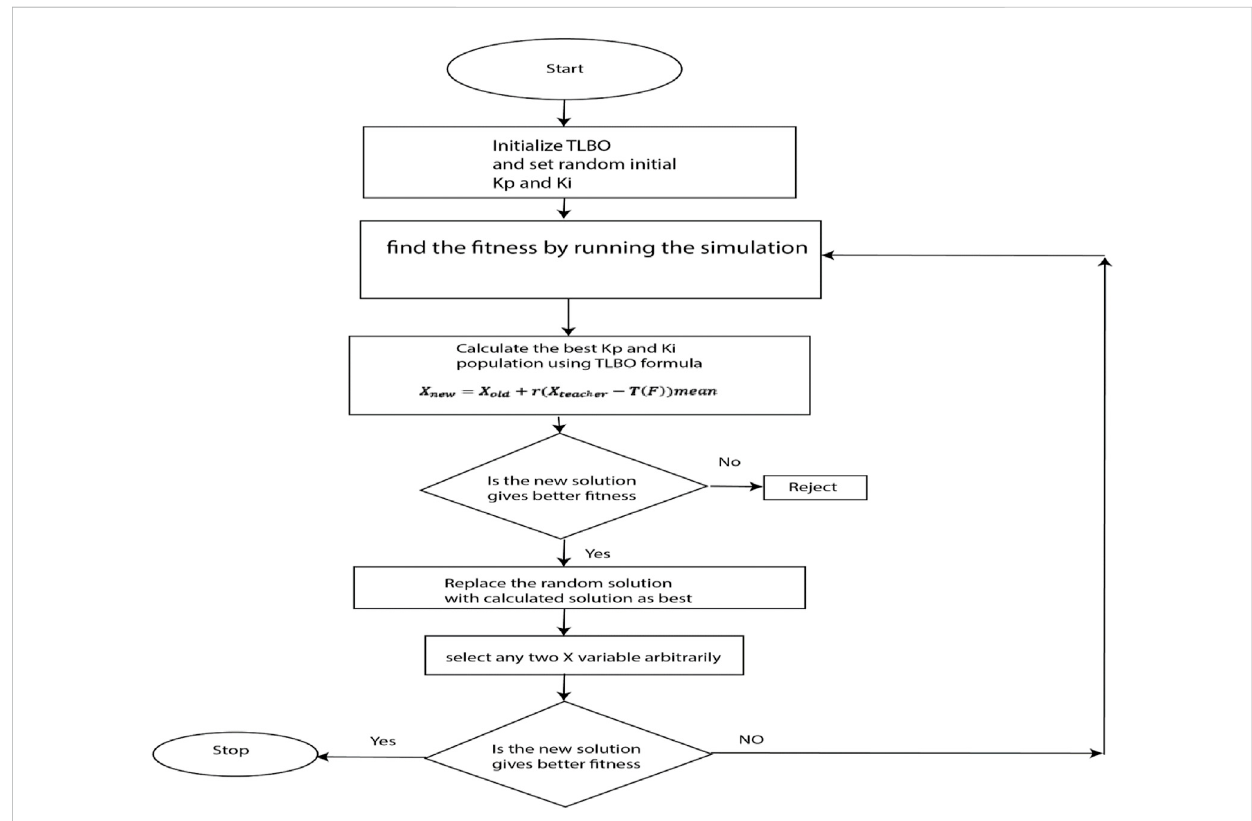
FIGURE 5 Proposed TLBO-based tuning procedure.